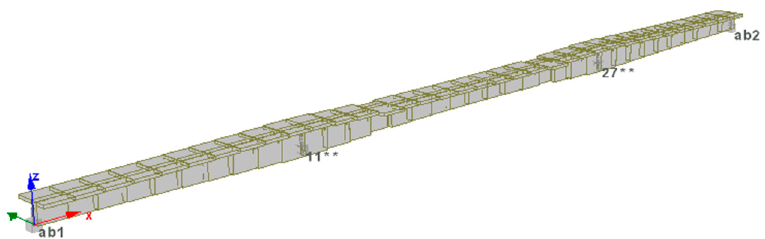
Figure 17. Schematic representation of the bridge 2 nonlinear model (** nodes at the bents).